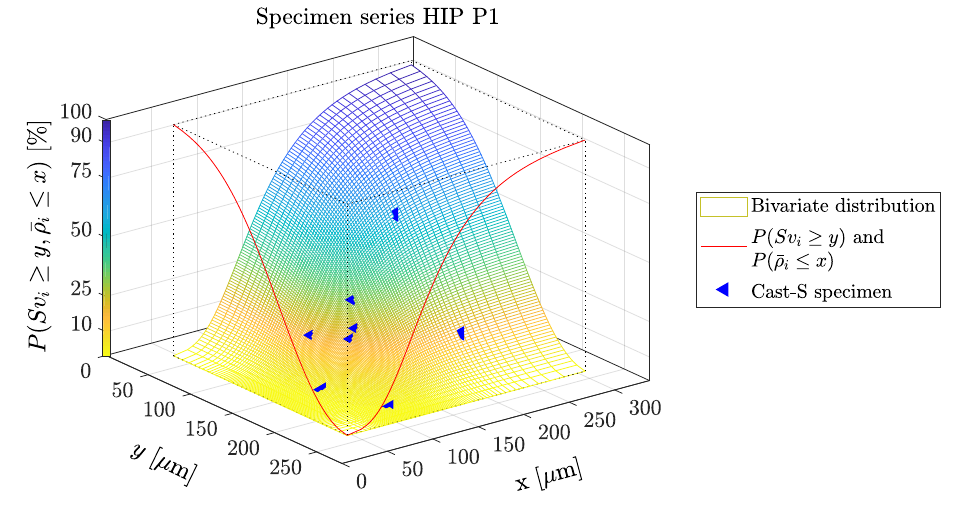
Figure A1. HIP P1 bivariate distribution of Sv i GEV distribution and ρ